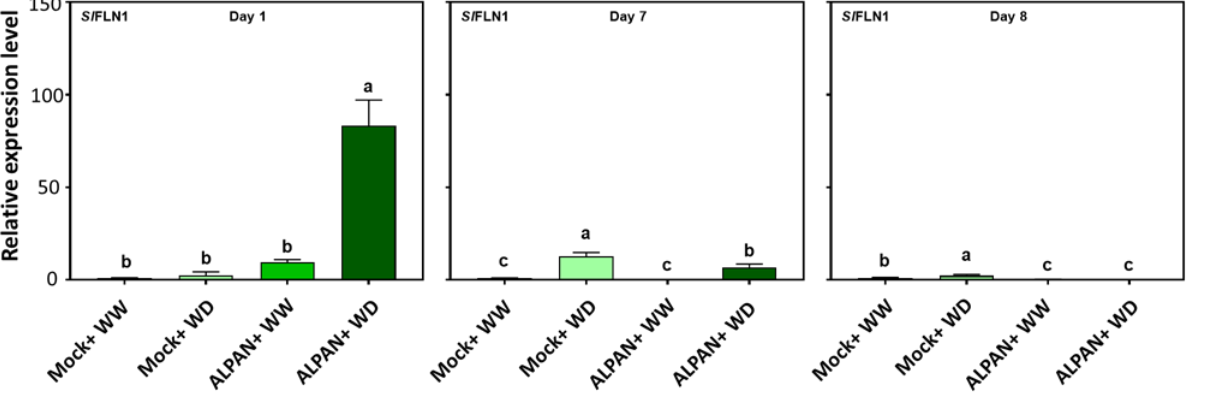
Figure 9. Expression levels of SlFLN1 after 1, 7, and 8 days of the initiation of the water deficit stress. WW = well watered, WD = water deficit. Error bars above histogram columns represent the standard deviation of four independent biological replicates in each experimental group at each sampling timepoint. The statistical data were analyzed with the use of the one-way ANOVA and Tukey’s post hoc tests, and a statistically significant difference ( p -value < 0.05) is denoted by a different letter above a histogram